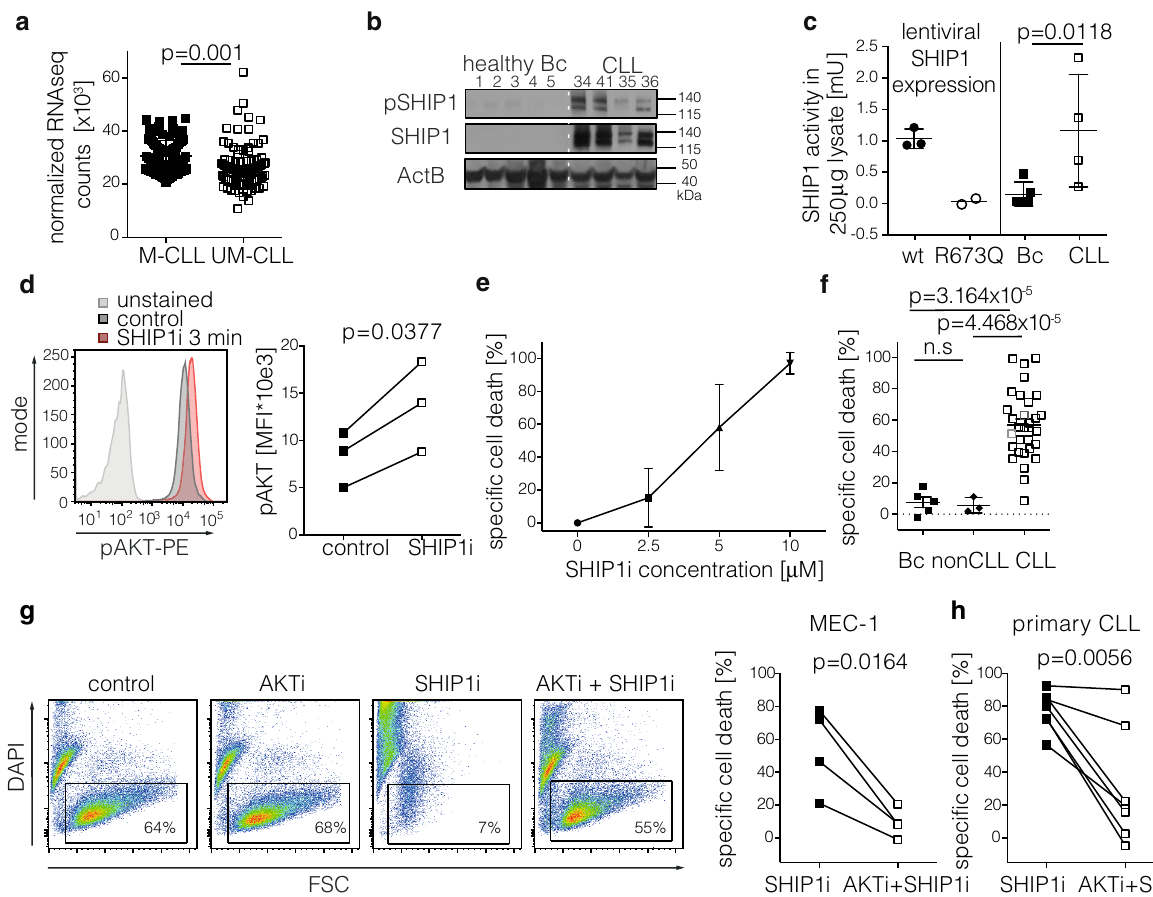
Fig. 2 SHIP1 activity in CLL samples is required to limit AKT signaling for CLL cell survival. a Normalized RNAseq counts of INPP5D mRNA (encoding SHIP1) are shown for IgV H -mutated CLL cases (M-CLL; black squares; n = 94) as compared to IgV H -unmutated CLL samples (UM-CLL; clear squares; n = 95); samples obtained from the peripheral blood. Data are presented as individual values and mean values±SD. Statistical signi fi cance was assessed by a two-tailed unpaired Student ’ s t -test. b Immunoblot of pSHIP1 Y1020 and global SHIP1 with beta-actin (ActB) as a loading control in MACS-isolated CD19 + peripheral blood B cells from healthy donors ( n = 5) as compared to CLL samples obtained from peripheral blood ( n = 4). Numbers indicated re fl ect the sample IDs of the CLL samples listed in Supplementary Table 1. c Direct phosphatase activity was determined using Malachite green assay after pulldown from 250 μ g protein isolated from (left) H1299 cells lentivirally overexpressing wt SHIP1 or the AML-derived R673Q variant of SHIP1 (as positive and negative control, respectively) and (right) healthy donor peripheral blood B cells ( n = 5) or primary peripheral blood CLL cells ( n = 4). Data are presented as individual values and mean values±SD. Statistical signi fi cance was assessed by a two-tailed unpaired Student ’ s t -test. The respective protein expression is shown in Supplementary Fig. S2c. d MEC-1 cells were treated with the SHIP1 inhibitor (SHIP1i) 3AC 5 μ M (red line) or vehicle (dark gray line) for 3min and subjected to intracellular pAKT staining; unstained control cells are indicated in light gray; representative FACS blot (left) and the summary of three independent experiments (right) is shown. Right: Data are presented as individual values for each experiment; statistical signi fi cance was assessed by a two-tailed paired Student ’ s t -test. e Cytotoxicity dose – response to increasing concentrations of the SHIP1 inhibitor 3AC in 28 primary CLL samples. The percentage of dead cells was determined by fl ow cytometry via DAPI staining. The percentage of speci fi c cell death was calculated as follows: 100 × (% dead cells − % baseline dead cells)/(100% − % baseline dead cells). Data are presented as mean values±SD. f Viability was determined upon 48h treatment with 5 μ M 3AC in vitro in CD19 + B cells from healthy donors ( fi lled squares), the B-cell lymphoma lines BJAB (human Burkitt lymphoma), SUDHL6 (human diffuse, mixed small and large cell lymphoma line), Bal17 (murine B-cell lymphoma; fi lled diamonds), and 28 primary CLL samples (clear squares) as well as the CLL-derived cell lines MEC-1 (light gray square) and EHEB (dark gray square), and the speci fi c cell death was calculated as described in e . Data are presented as individual values and mean values±SD. Statistical signi fi cance was assessed by a two- tailed unpaired Student ’ s t -test. g MEC-1 cells were treated with vehicle (control), treated with the AKT inhibitor AZD-5363 (5 μ M) alone, or in combination with 3AC (5 μ M). Left: representative fl ow cytometry analysis of DAPI negative, viable cells upon the treatments. Right: the speci fi c cell death was determined as described in e , measured in four independent experiments. Data are presented as individual values for each experiment and statistical signi fi cance was assessed by a two-tailed paired Student ’ s t -test. h Primary CLL cells derived from the peripheral blood of 7 donors were treated with vehicle (control), treated with the AKT values per CLL donor and statistical signi fi cance was assessed by a two-tailed paired Student ’ s t -test. Source data are provided as a Source Data fi